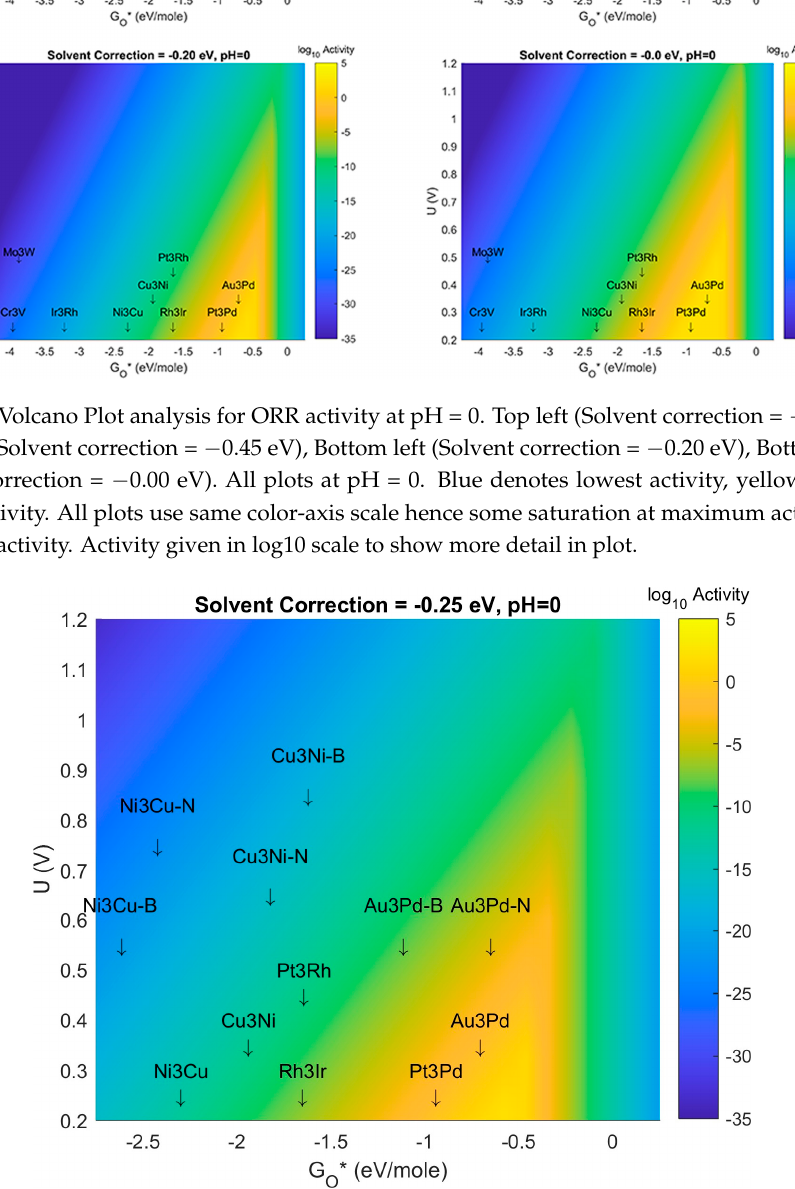
Figure 11. Volcano Plot with calculated descriptor values for 4-atom intermetallic MDG NP on B-doped and N-doped graphene. "-B" denotes Boron doping, "-N" denotes Nitrogen doping. Same color scheme and unit conventions as previously used in prior Volcano Plot(s) in this manuscript.